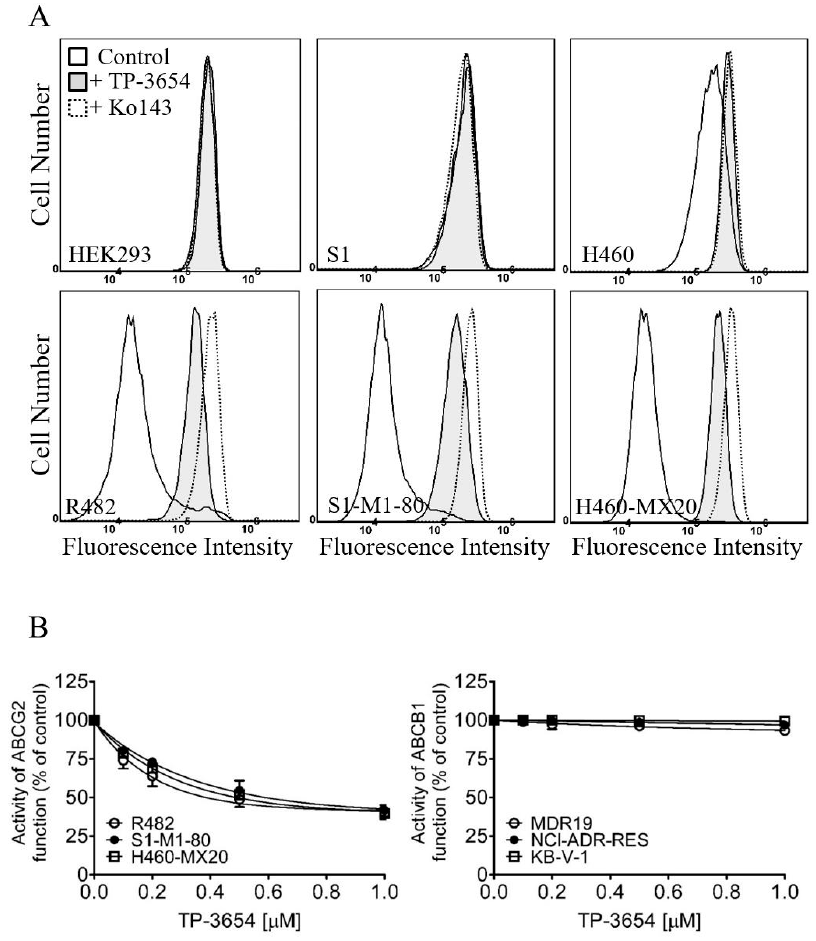
Figure 2. TP-3654 increases the intracellular accumulation of pheophorbide A (PhA) in ABCG2- overexpressing cells. ( A ) Flow cytometry analysis of PhA accumulation in parental HEK293 cells and ABCG2-transfected R482-HEK293 cells (left panels), parental S1 and ABCG2-overexpressing S1-M1-80 cells (middle panels), and parental H460 and ABCG2-overexpressing H460-MX20 cells (right panels) treated with DMSO (control, solid lines), 1 µ M of TP-3654 (filled solid lines), or 1 µ M of Ko143 as a positive control (dotted lines) for ABCG2. ( B ) Effect of increasing concentrations (0–1 µ M) of TP-3654 on ABCG2-mediated efflux of PhA (left panel) in ABCG2-overexpressing R482-HEK293 cells (open circles), S1-M1-80 (filled circles), and H460-MX20 cells (open squares), and on ABCB1-mediated efflux of calcein-AM (right panel) in ABCB1-overexpressing MDR19-HEK293 cells (open circles), NCI-ADR-RES (filled circles), and KB-V-1 cells (open squares). Data represent means ± S.D. from at least three independent experiments.